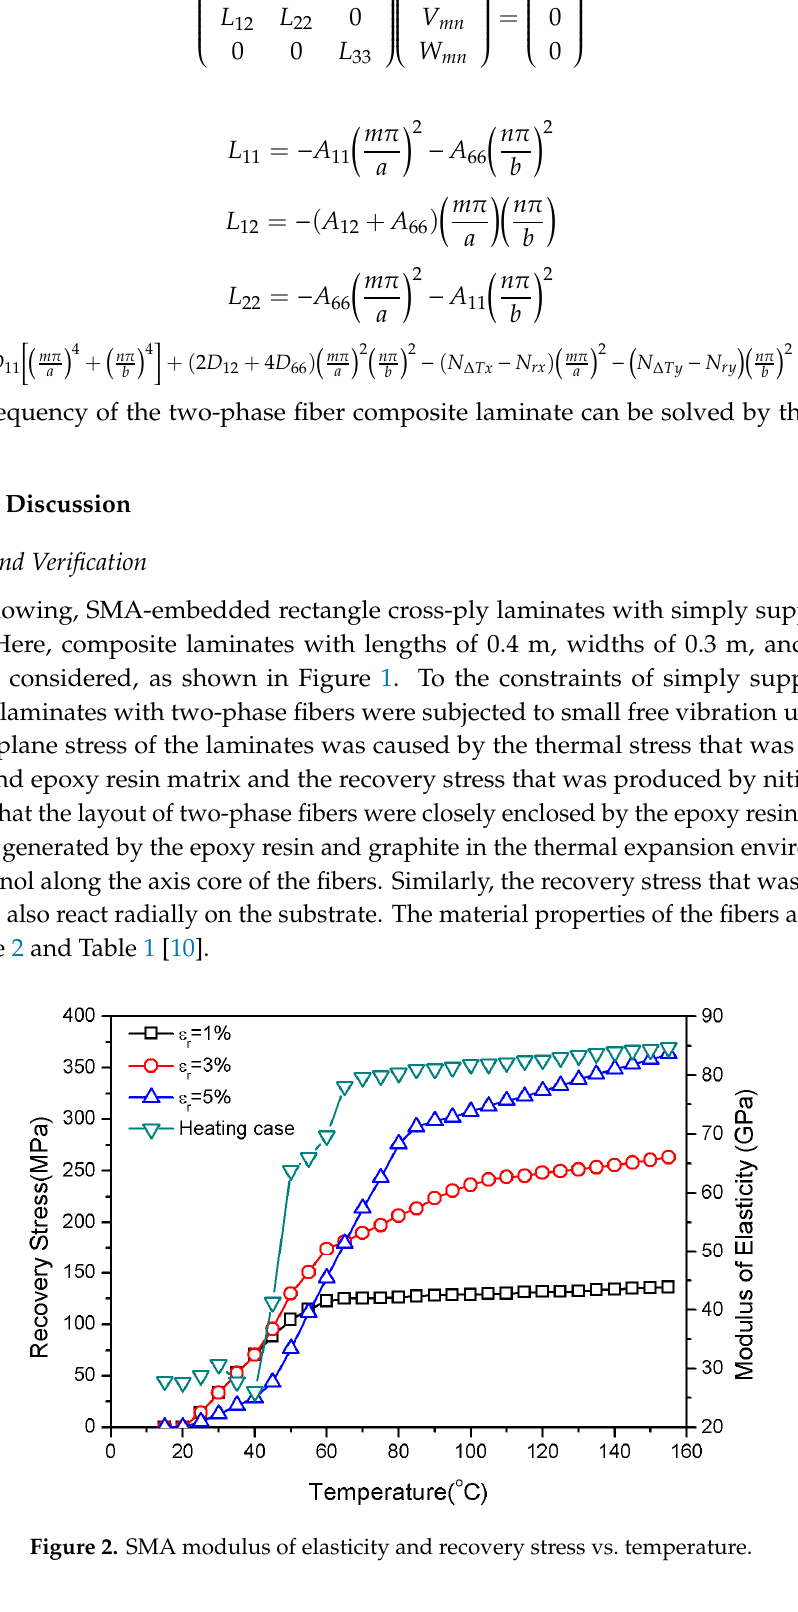
64.80 × 10 − 6 Figure 3. Dimensionless natural frequency vs. temperature. Table 2. Comparison of dimensionless natural frequencies. Dimensionless natural frequency (  ) o T 30 C 